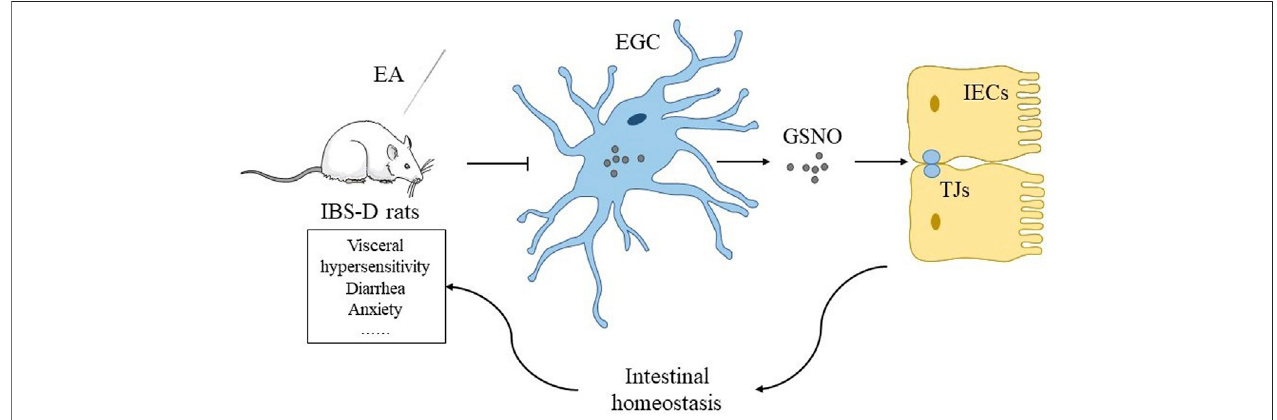
FIGURE1| HypothesisofthemechanismofEAmaintainingintestinalhomeostasisbyregulatingexpressionsoftightjunctionproteinsthroughEGC-derivedGSNO in IBS-D